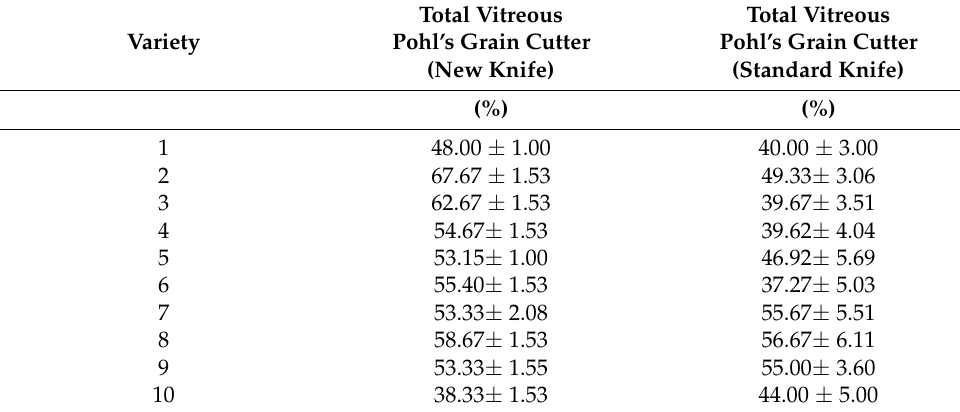
Table 3. The average values of vitreous of the wheat sample (10